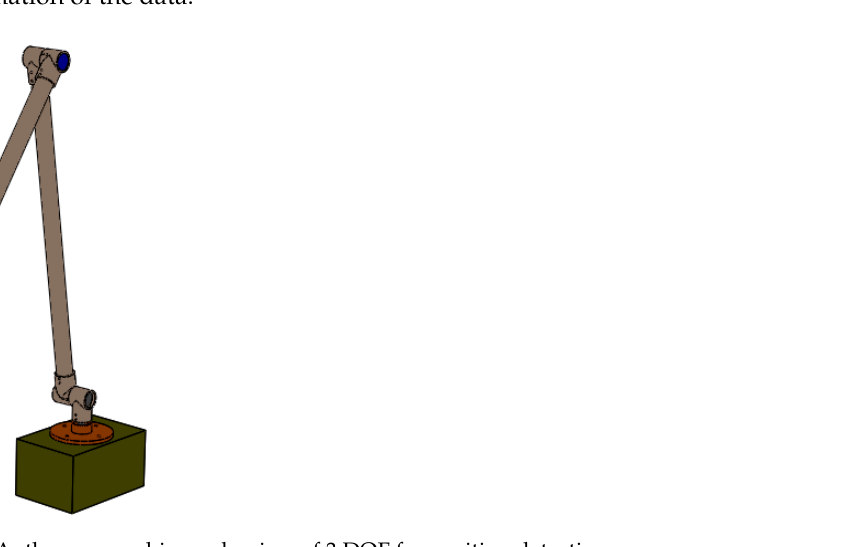
Figure 4. Diagram of the reference frame of the three-degrees-of-freedom anthropomorphic mechanism. The nomenclature used for homogeneous transformation matrices is as follows: c θ 1 = c 1 ; c θ 2- 10° = c 2 ; c θ 3 +10° = c 3 ; s θ 1 = s 1 ; s θ 2 -10° = s 2 ; s θ 3 +10° = s 3 . The Denavit- Hartemberg parameters are shown in Table 2.